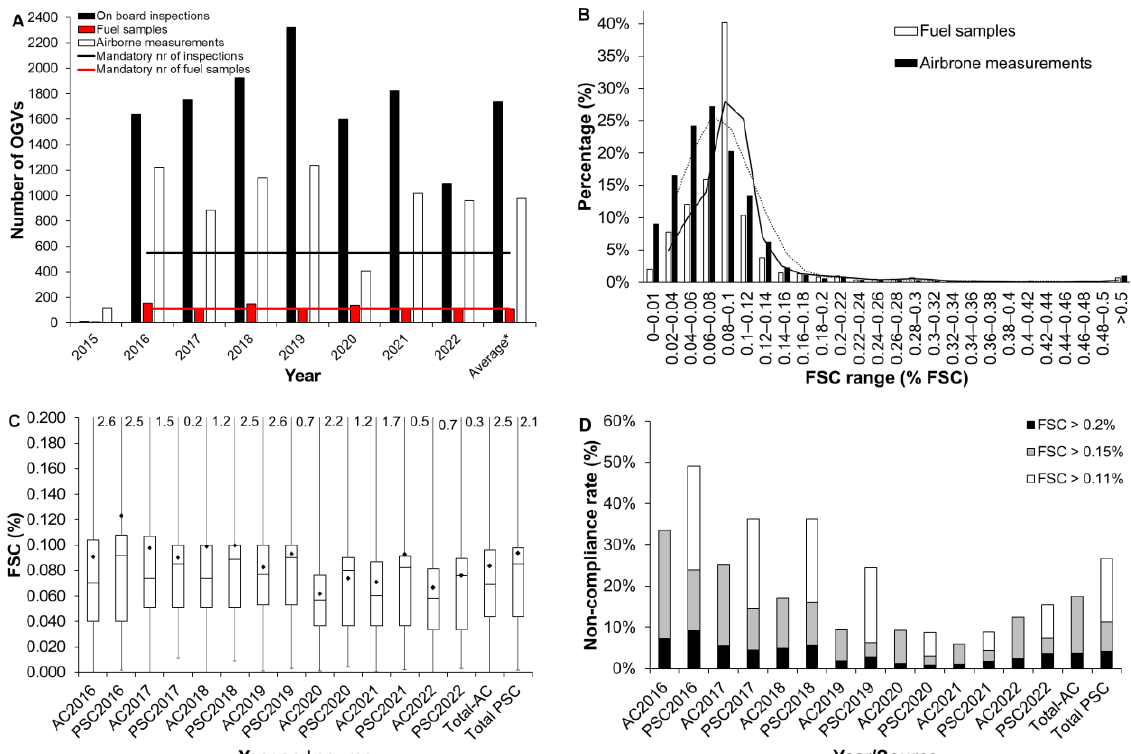
Figure 2. Overview of the number of mandatory and executed onboard inspections ( black ) and fuel samples ( red ) undertaken by Belgian port inspection authorities and airborne measurements ( white ) ( A ). Comparisons of observed FSC values and moving averages of fuel samples with airborne measurements between 2016 and 2022 ( B ). Boxplot comparison of FSC between fuel samples and airborne measurements with 25, 75% percentile, median values, and average values ( ♦ ) ( C ). Comparison of compliance rates between port inspections and airborne monitoring between 2016 and 2022 ( D ).